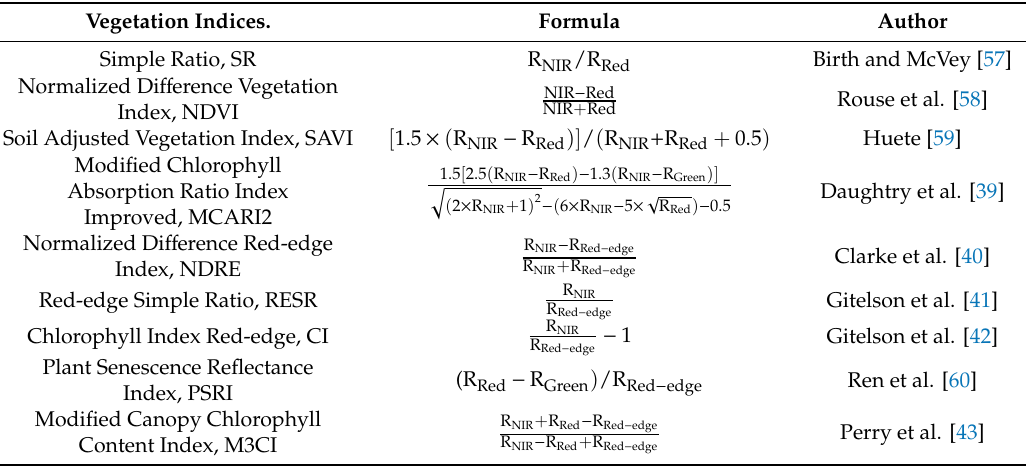
Figure 4. Examples of zoomed tree canopies on different tree species and health status from both seasonal periods in RGB spectral bands. Table 3. Reflectance indices used in chronological